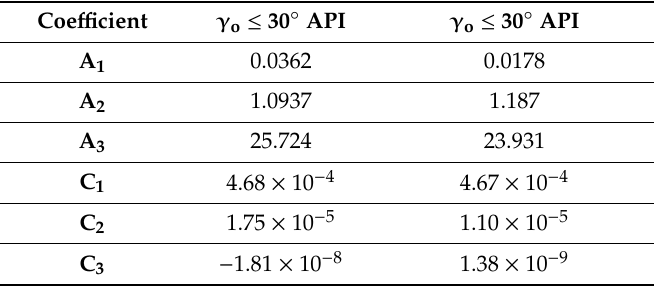
Table A6. Coe ffi cients for the Vazques-Beggs correlations